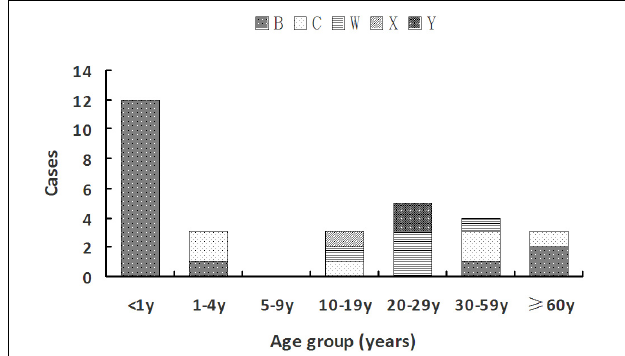
FIGURE 1 | Serogroup distribution of Nm among different age groups during 2011–July 2021 in Zhejiang Province.